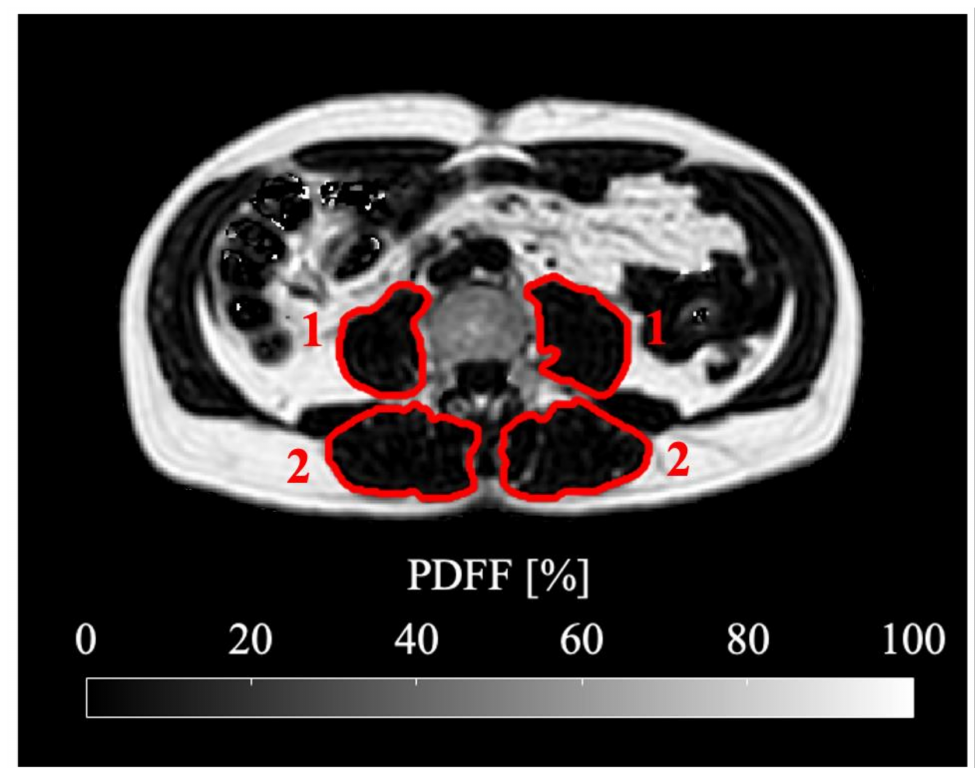
Figure 1. Representative segmentation of psoas (1) and erector spinae (2) muscle shown in the PDFF map at the level of the fourth lumbar vertebra (L4). The subject is a 60-year-old male with a BMI of 26.0 kg/m 2 suffering from ductal adenocarcinoma of the